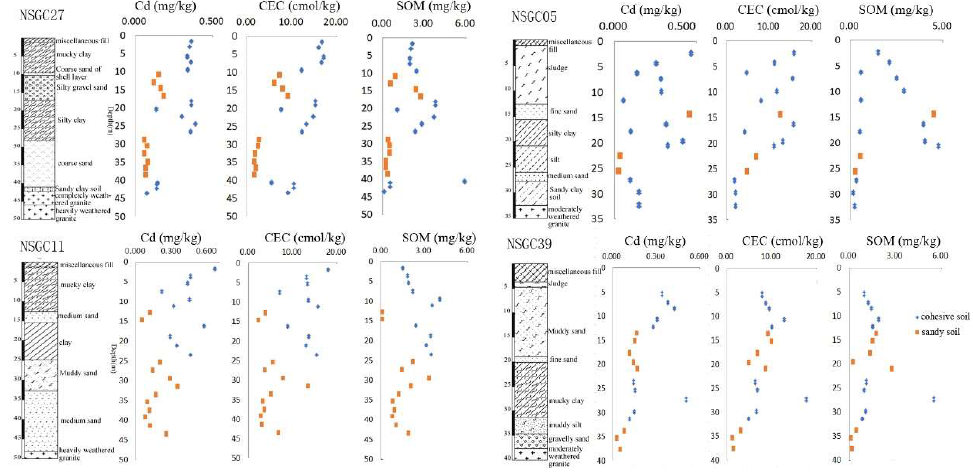
Figure 3. Cd, cation exchange capacity (CEC), and soil organic matter (SOM) distribution in the cores.